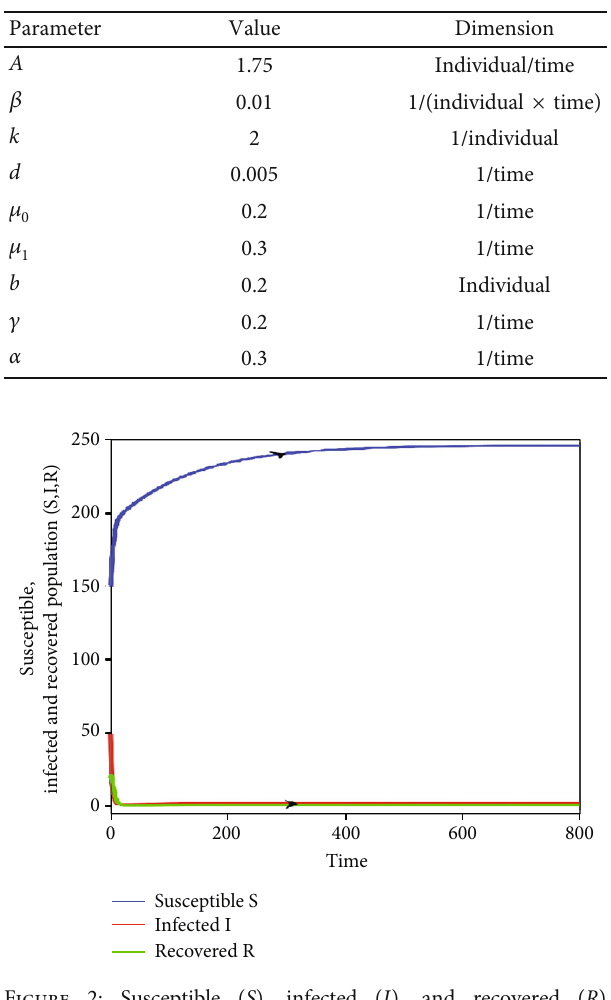
Figure 2: Susceptible ( S ), infected ( I ), and recovered ( R ) individuals as functions of time.